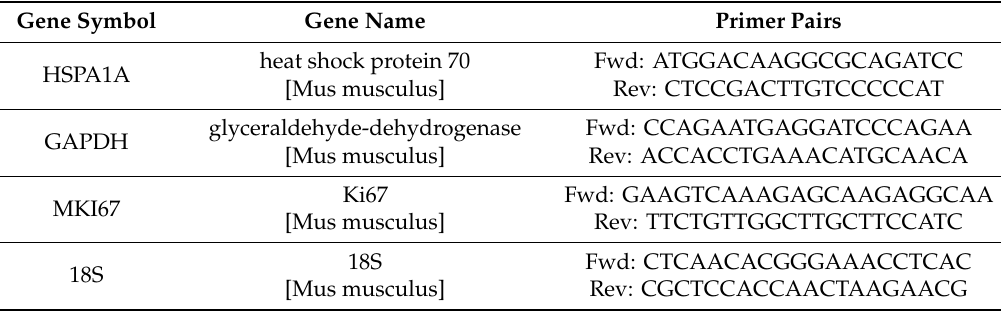
Table 2. Primers used for